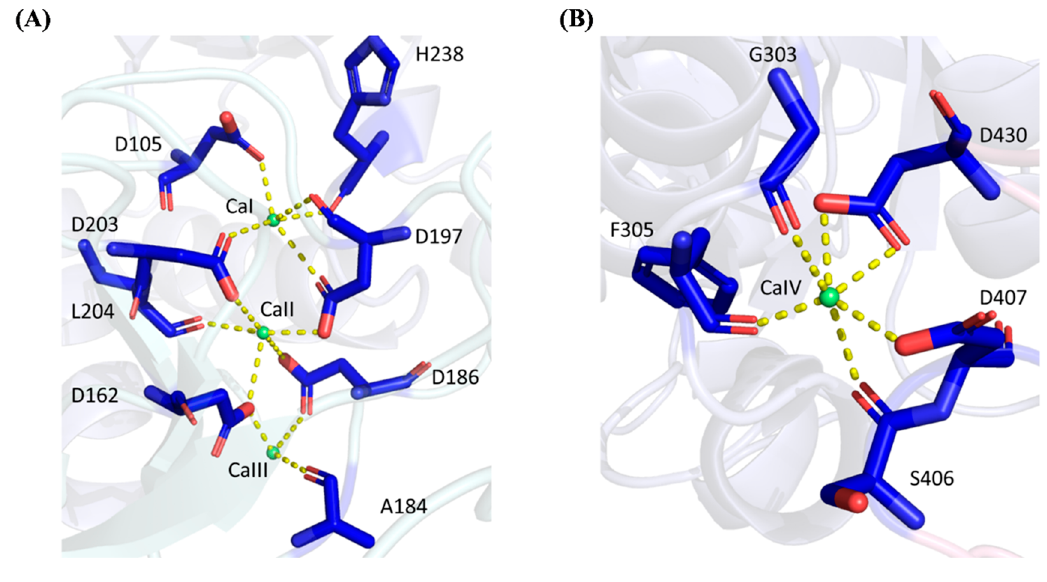
Figure 3. Polar interactions between calcium ions and SR74 α -amylase. ( A ) CaI, CaII and CaIII interact with 8 residues via polar bonds. D197 and D203 form polar linkages with CaI and CaII while D162 and D186 interact with CaII and CaIII at the same time. ( B ) CaIV possesses polar interactions with 5 residues. Yellow dashed lines showed the polar interactions between residues and respective calcium ions.